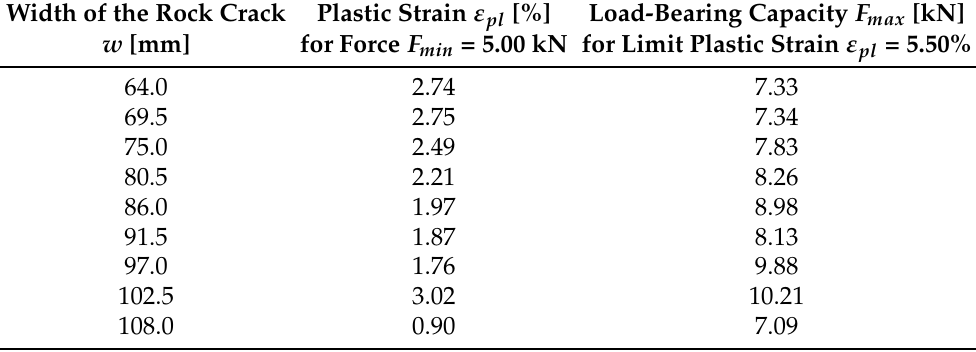
Table 8. Load-bearing capacity for different rotations of